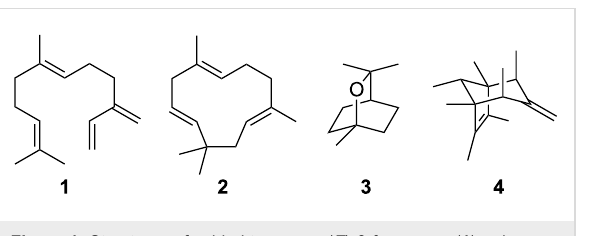
Figure 1: Structures of achiral terpenes: ( E )- β -farnesene ( 1 ), α -humu- lene ( 2 ), 1,8-cineol ( 3 ) and sodorifen ( 4 ).